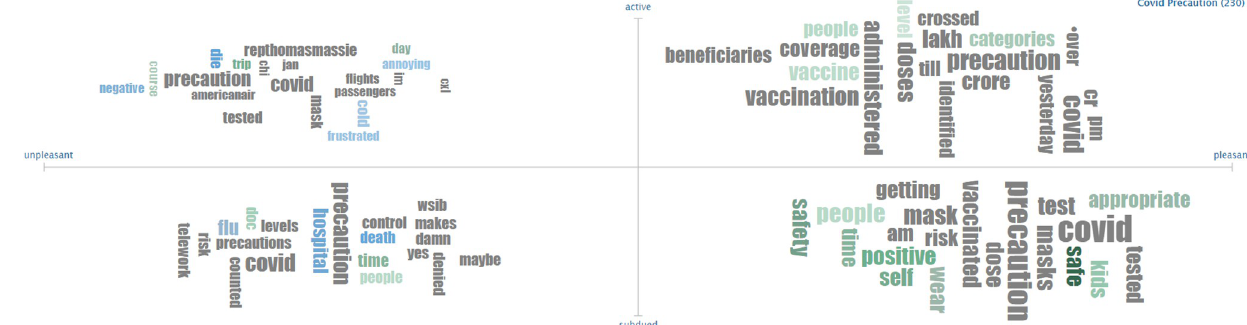
Fig 16. Word cloud in terms of pleasant and unpleasant categories.